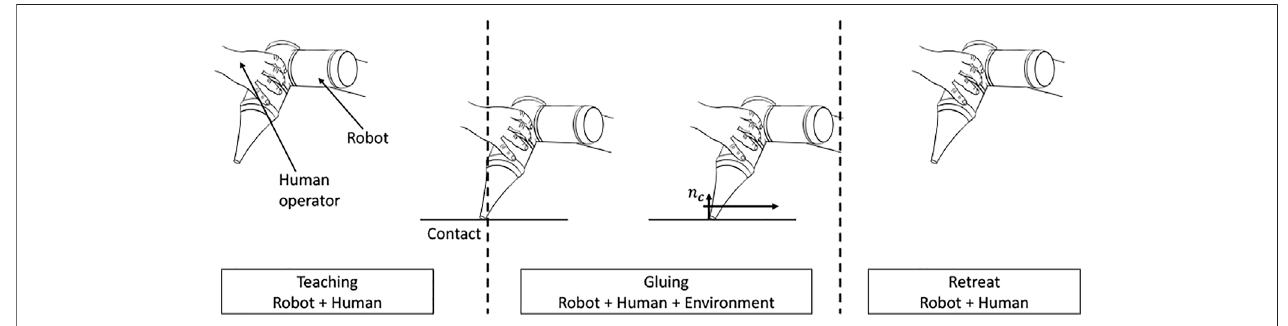
FIGURE 2 | Idea of the